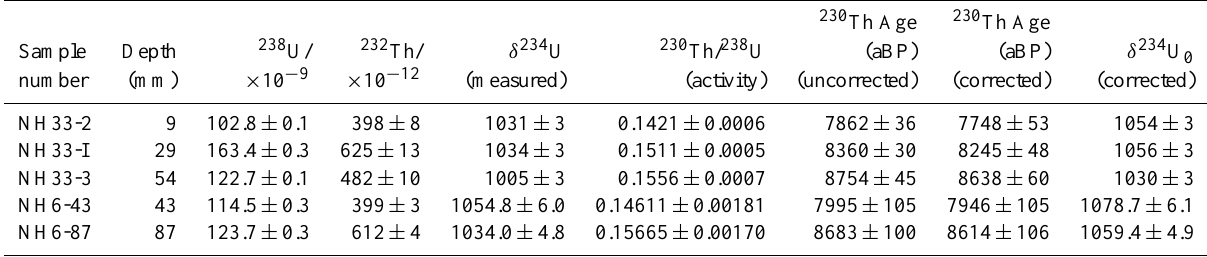
Table 1. 230 Th dating results from stalagmite NH from Nuanhe Cave,